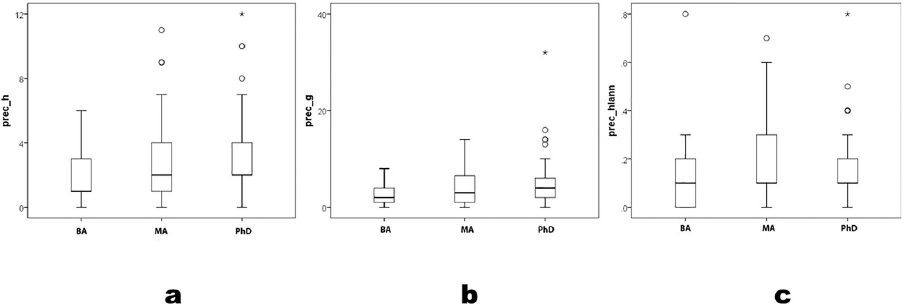
Fig 1. prec_ h , prec_ g and prec_ hIann by degree